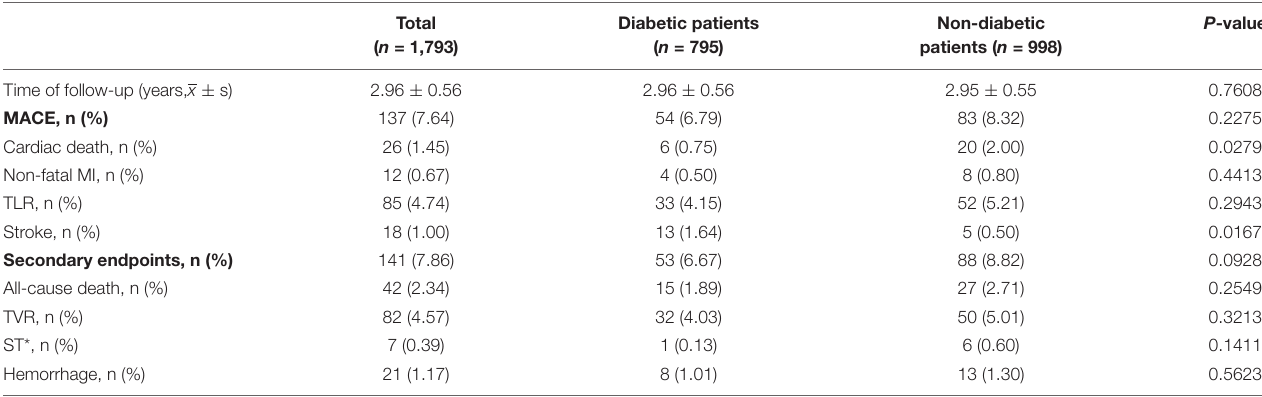
TABLE 2 | Follow-up of patients with coronary artery